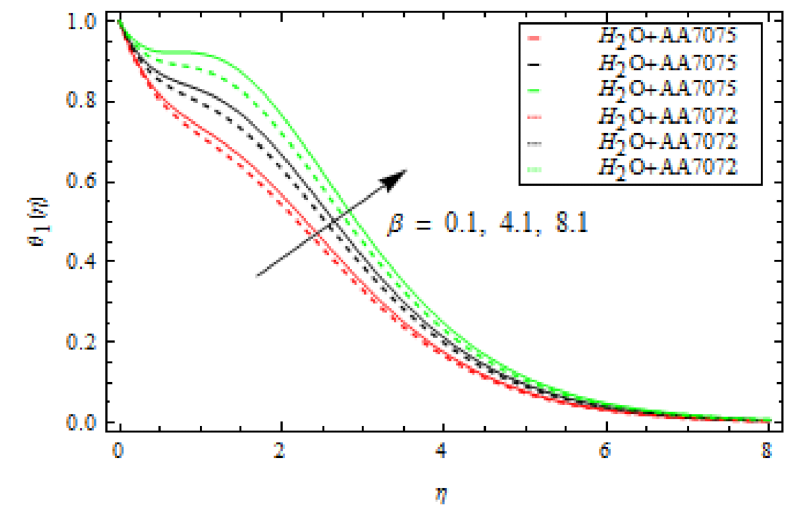
Figure 8. Influence of ferromagnetic interaction parameter β on temperature profile.